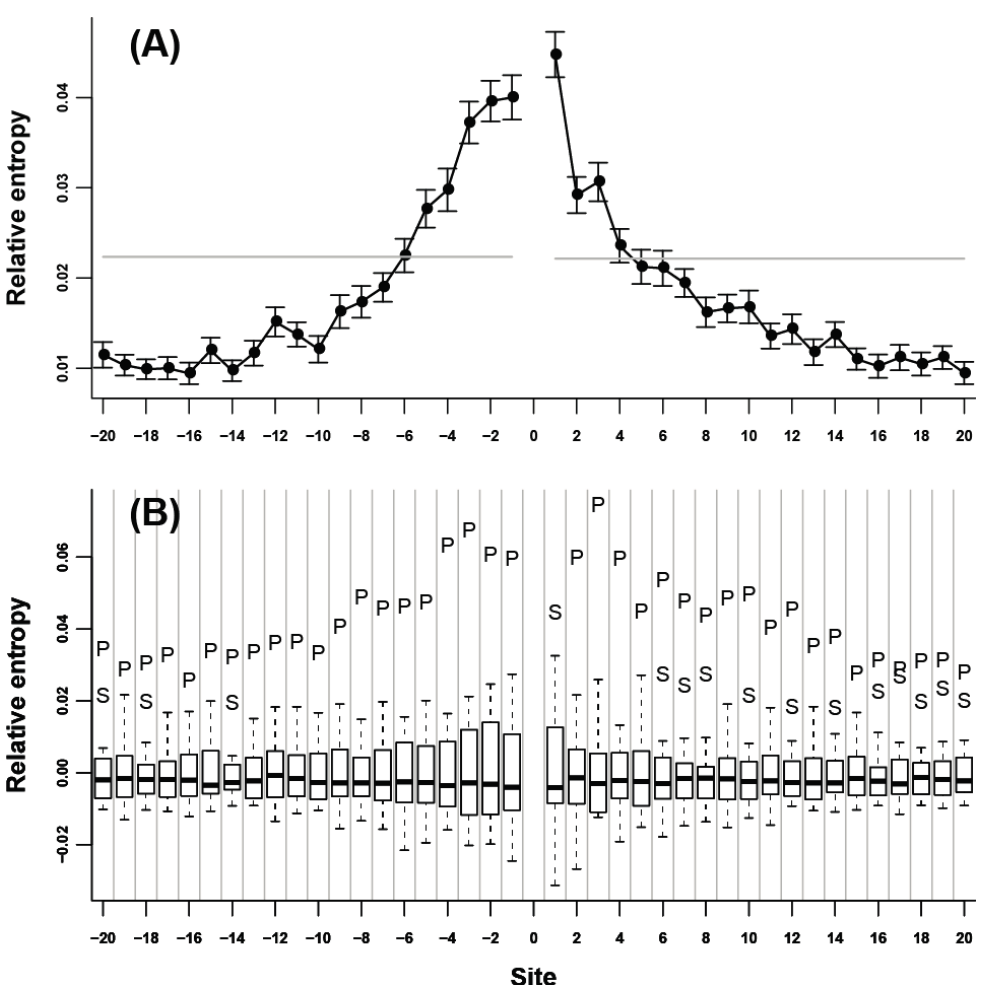
Figure 5. Context-dependence pattern of S → P substitution. ( A ) Relative entropies of the neighboring sites of the S → P substitution of N - and C -termini; ( B ) Boxplot of the 20 relative entropies at each flanking site of the S → P